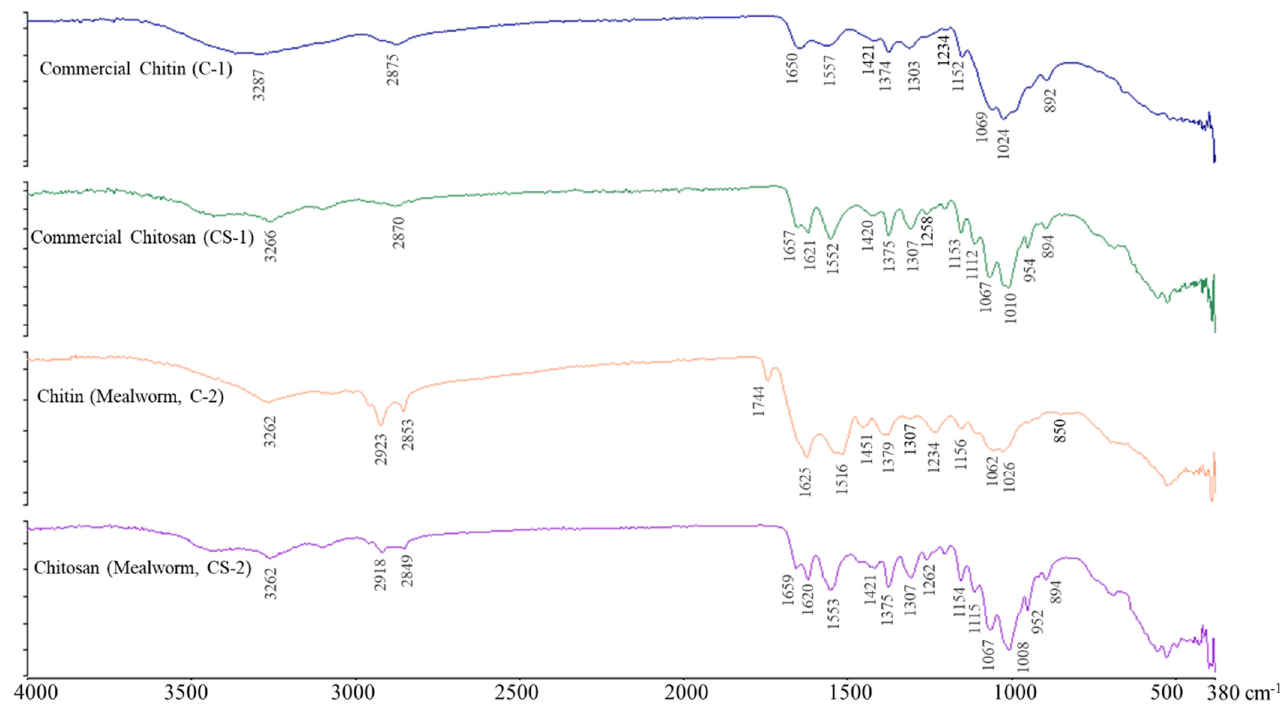
Figure 3. FT-IR spectrophotogram of commercial chitin (C-1), chitosan (CS-1), chitin (C-2), and chi- tosan (CS-2) from mealworm larvae. chitosan (CS-2) from mealworm